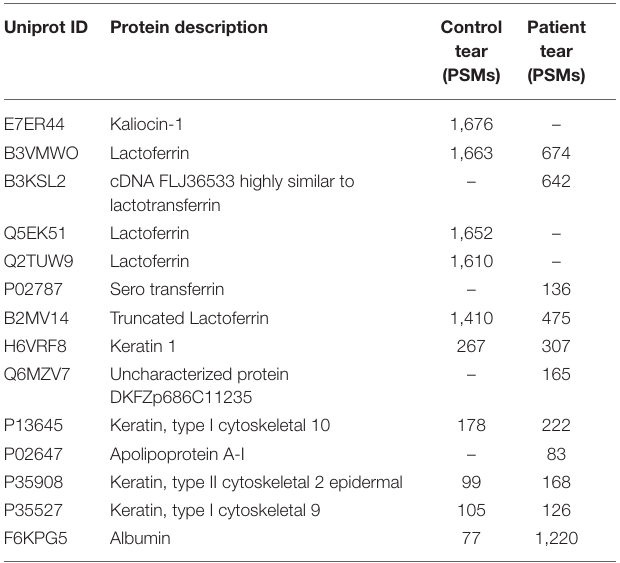
(B) COMPARISON OF THE SPORE BOUND PROTEINS OF CONTROL AND PATIENT TEAR